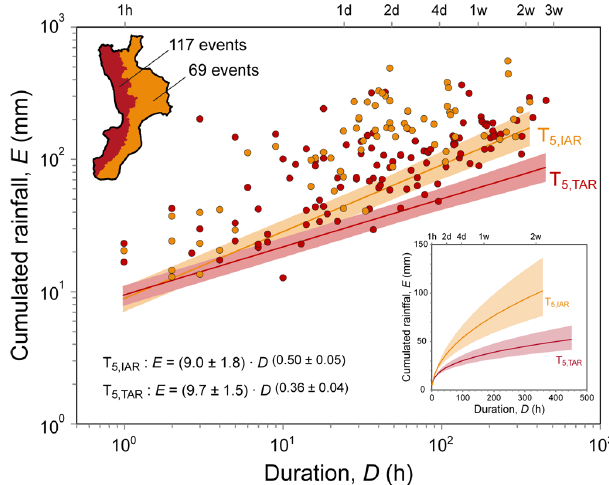
Fig. 10. Rainfall duration vs. cumulated event rainfall ( D,E) con- ditions that resulted in shallow landslides in Calabria in the Ionian alert region (orange dots) and in the Tyrrhenian alert region (red dots), and related ED thresholds at the 5% exceedance probabil- ity levels (T 5,IAR and T 5,TAR ) . Inset shows the thresholds in linear coordinates. Shaded areas show uncertainties associated with the